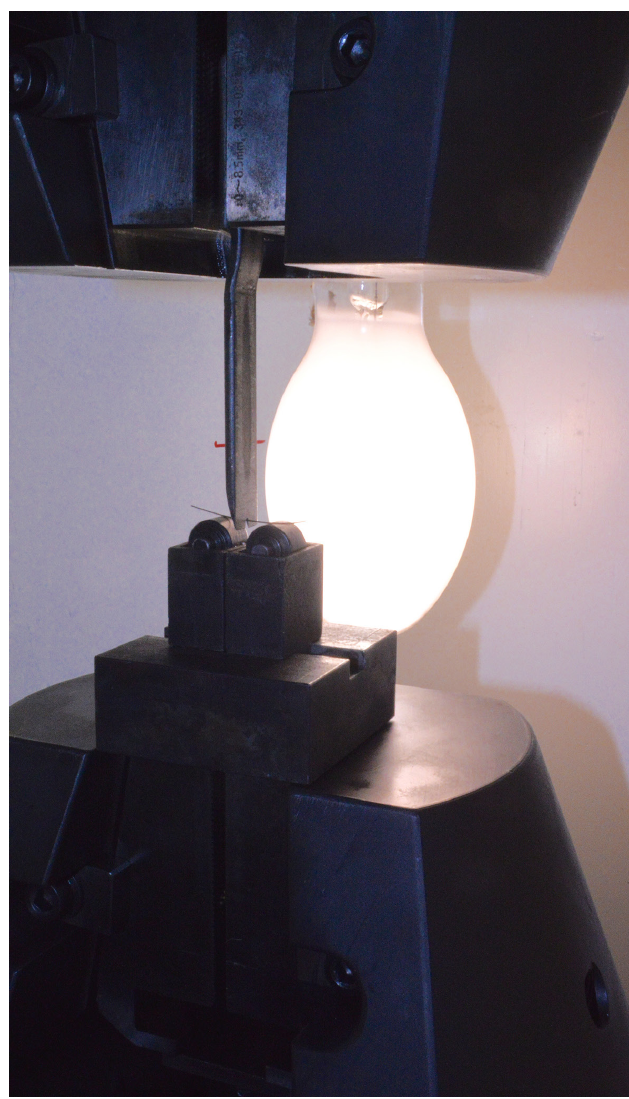
Fig. 1 - Specimen positioned for three-point bending test at 37